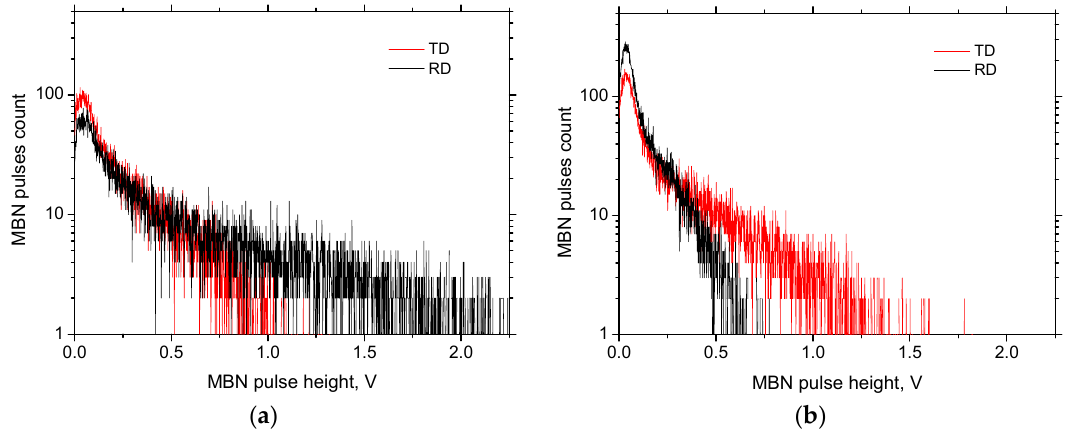
Figure 16. Distribution of MBN pulses height. ( a ) ε = 2.5%; ( b ) ε = 40%.